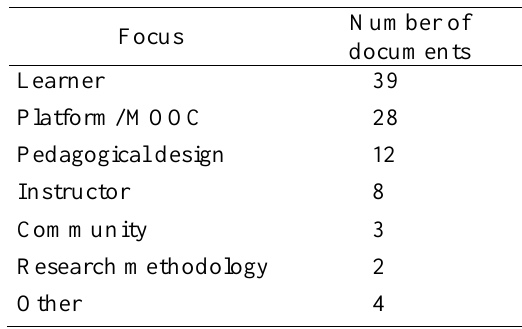
Main Focus of the Case Studies